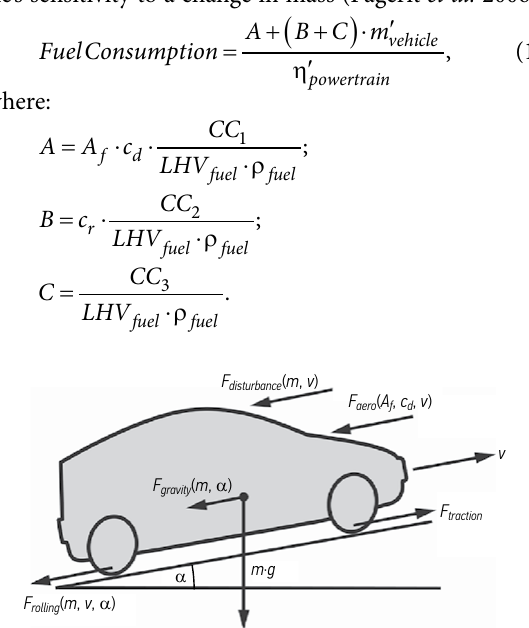
Fig. 2. Vehicle mass influences many of the forces acting on a linear dynamics vehicle